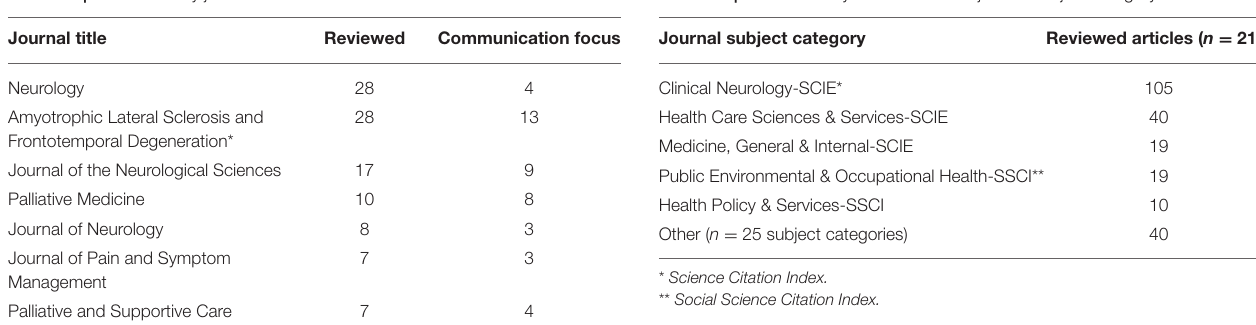
TABLE 1 | Distribution by journal title. TABLE 2 | Distribution by Web of Science journal subject